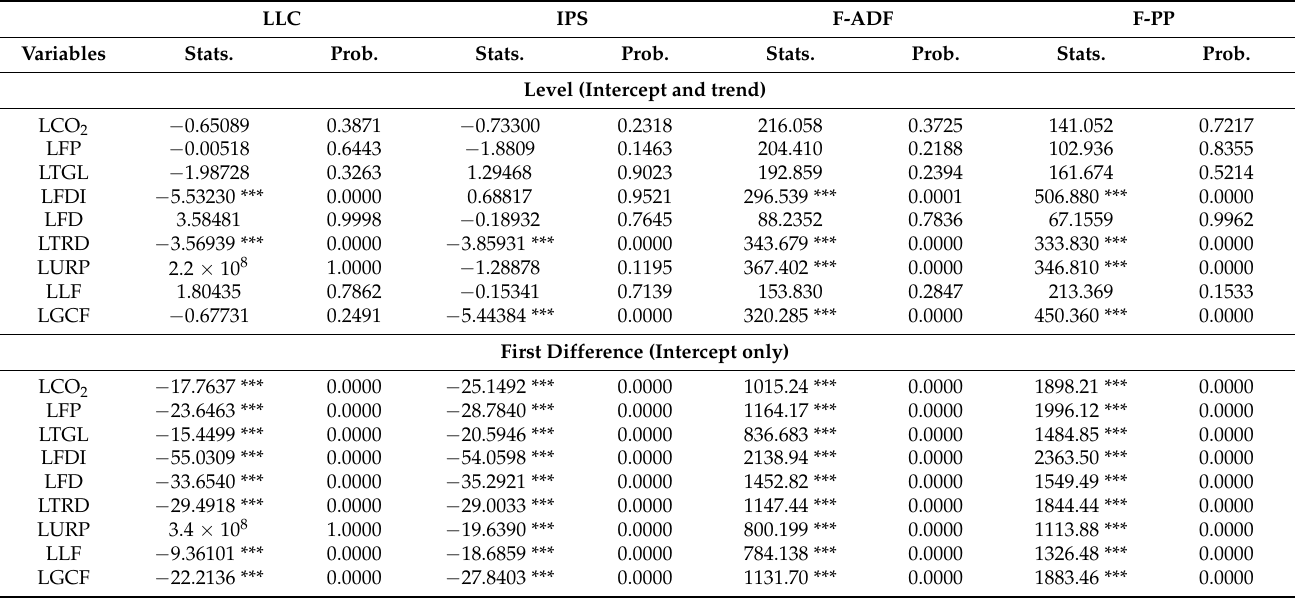
Table 5. Results of panel unit root